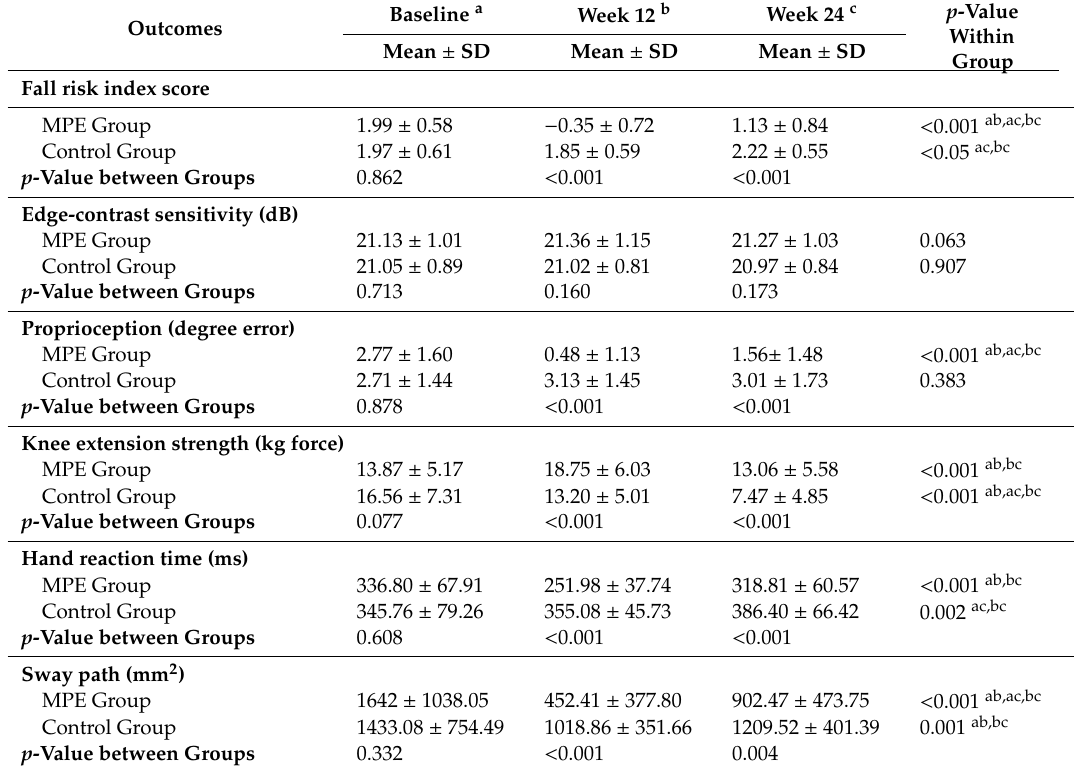
Table 3. Comparison of fall risk between intervention and control